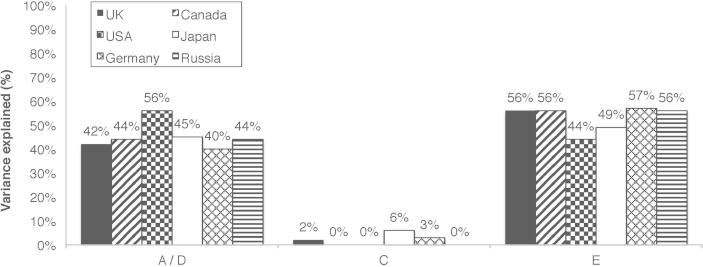
Relative contributions of genetic (A/D), shared (C) and non-shared (E) environmental factors to individual differences in academic motivational traits by country, averaged across age, school subject and construct. Enjoyment of German language at age 9 was excluded from the figure as this sample produced anomalous result of absence of genetic effects.